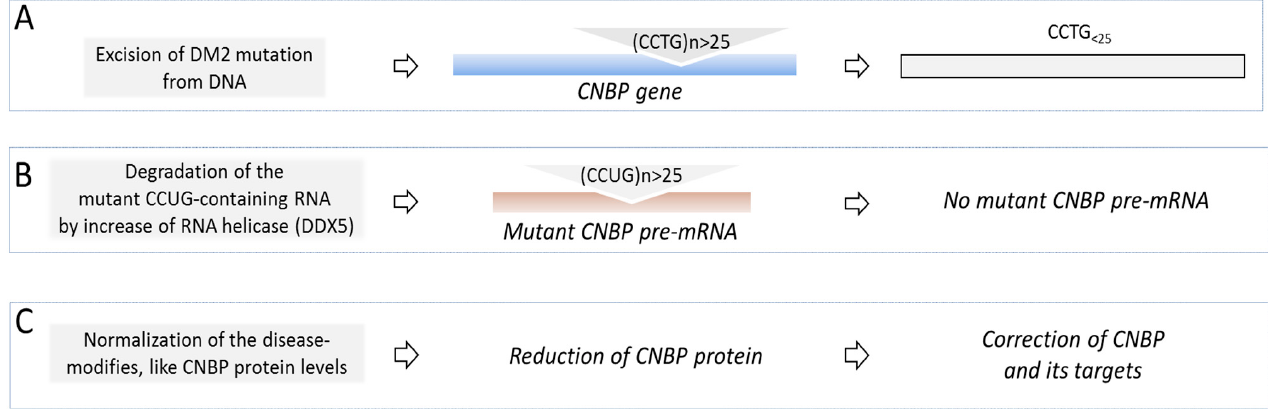
Figure 4. ( A – C ): The models of the proposed therapeutic approaches for DM2 (see text). Mutant CNBP gene and CNBP mRNA are shown as blue and brown boxes.